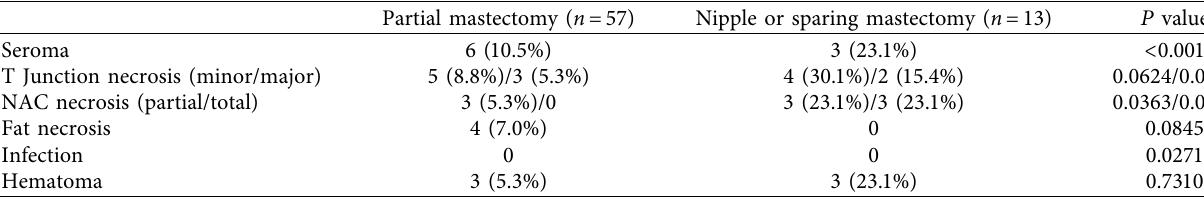
Table 2: Postoperative